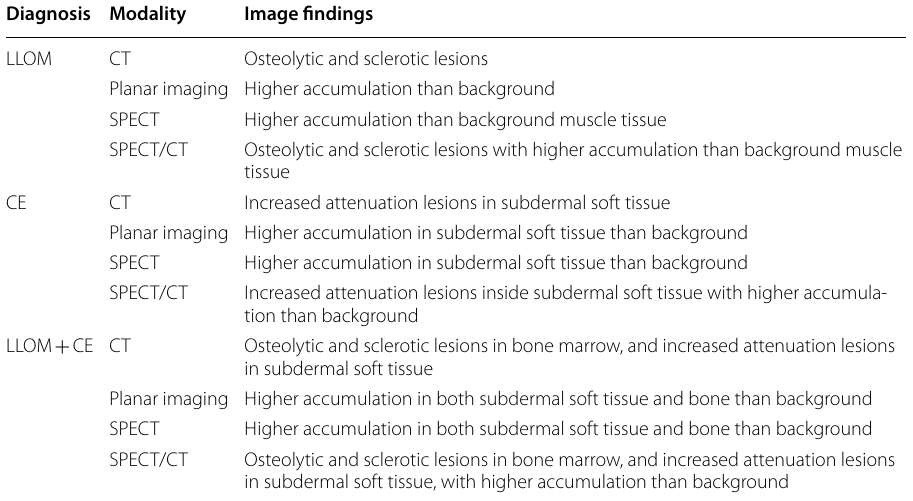
Table 1 Procedure to identify LLOM positive cases using visual assessments Diagnosis